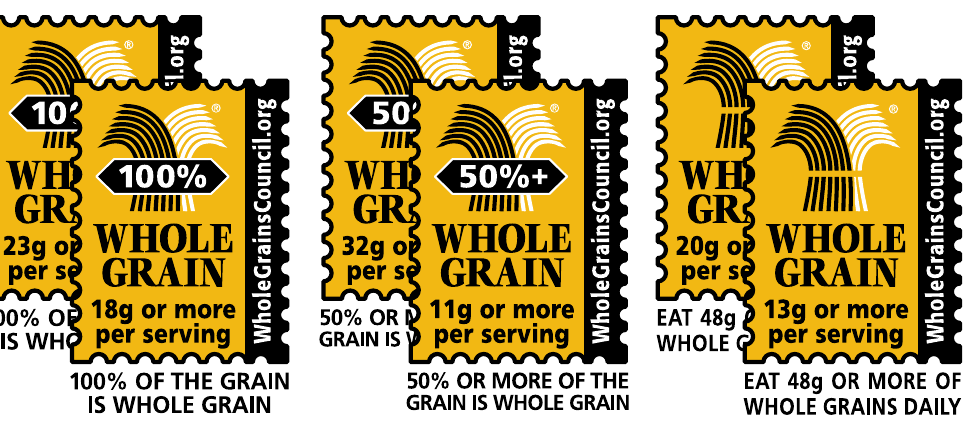
Figure 1. Whole Grain Stamps.